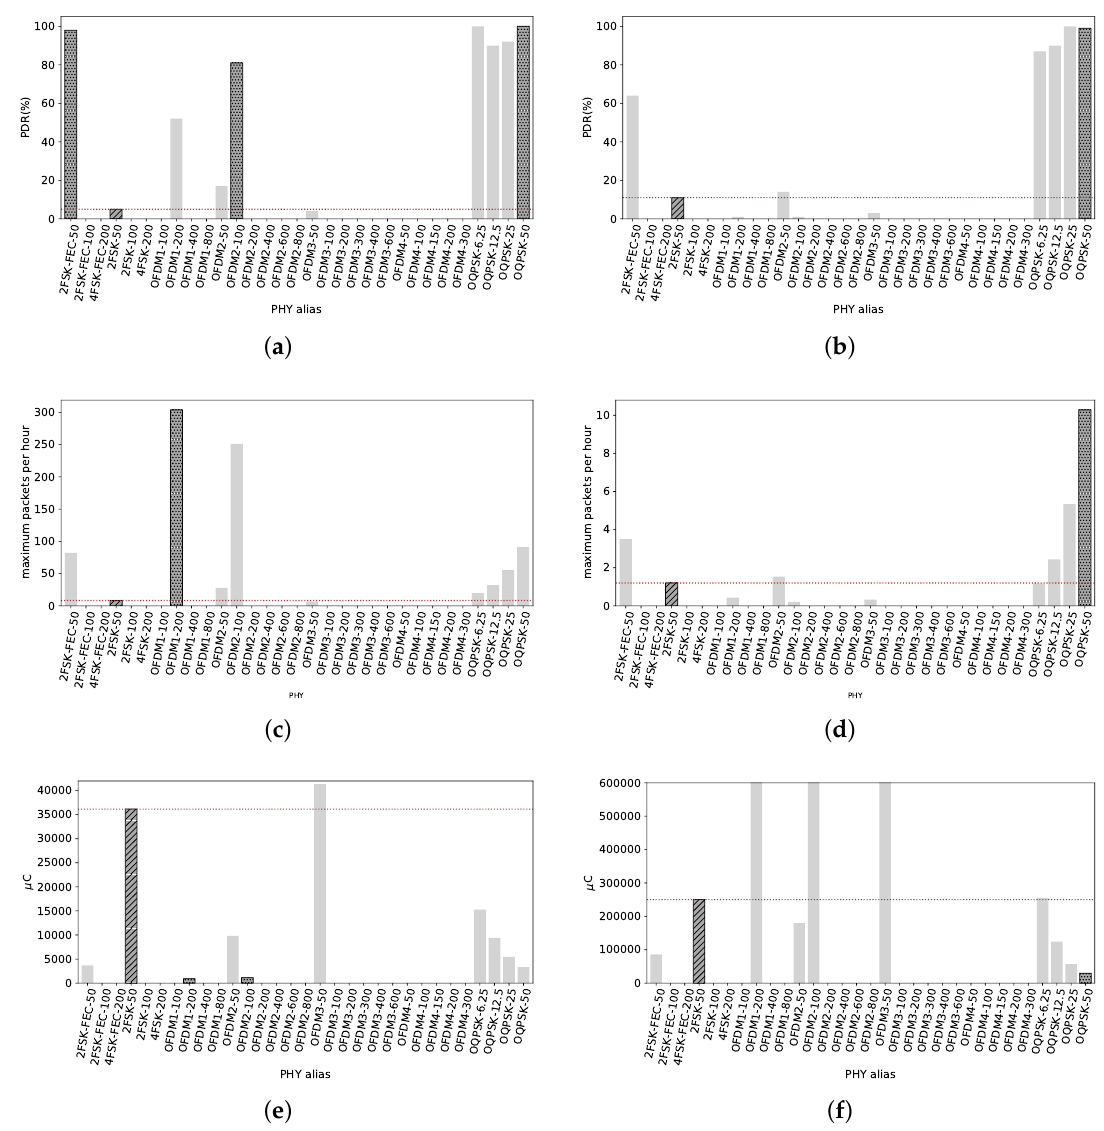
Figure 10. Smart Agriculture, 615 m. The radio link is very close to the maximum distance where it can deliver connectivity. High data rates OFDM radio settings are unable to get any packet across. Maximum data rate that can provide connectivity is 200 kbps, but with PDR of 52% with short packets. ( a ) PDR values for all radio settings with short packets. Only 2FSK-FEC-50, OFDM2-100 and all the O-QPSK radio settings have a PDR over 80%. The reference has a poor PDR, only 5%; ( b ) PDR values considering long packets. Only O-QPSK PHYs have PDR values over 85%, against the reference with 11%; ( c ) Maximum amount of TXs with short packets under 0.1% duty cycle. Despite its PDR of 52%, OFDM1-200 is able to transmit up to 300 short packets. The reference can send just 8 packets; ( d ) Maximum amount of TXs with long packets within one hour. OQPSK-50 can send up to 10 long packets while the reference roughly 1 packet per hour; ( e ) Energy consumed per 127 B packet transmitted. OFDM1-200 and OFDM2-100 are the most electric charge-efficient, consuming 895 µ C and 1095 µ C respectively. The reference consumes 36 mC. This is due to its poor PDR; ( f ) Energy consumed per 127 B packet transmitted. O-QPSK is the less electric charge-consuming radio setting, with 29.5 mC while the reference consumes 250